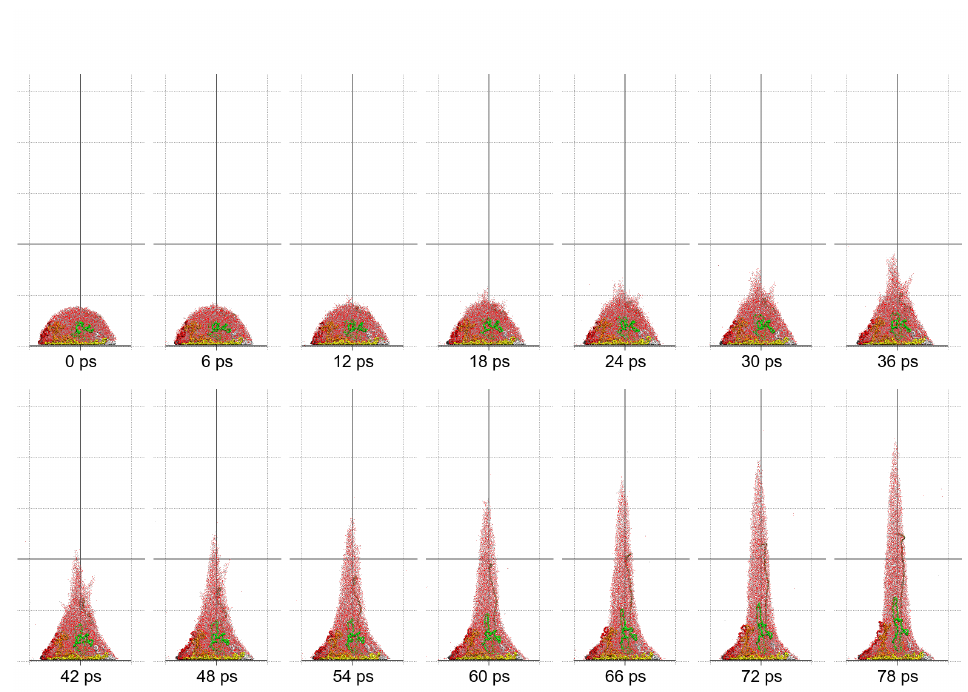
Figure 7. Snapshots from a production trajectory of the system with eight 10.55-kDa chains and no ion pairs under the applied electric field of 1.5 V/nm—time evolution from 0 to 78 ps in 6-ps steps. As a visual aid, a 10-by-10-nm grid is displayed. For color scheme see Figure 3. Graphics made with Visual Molecular Dynamics [46] and ImageMagick [55].